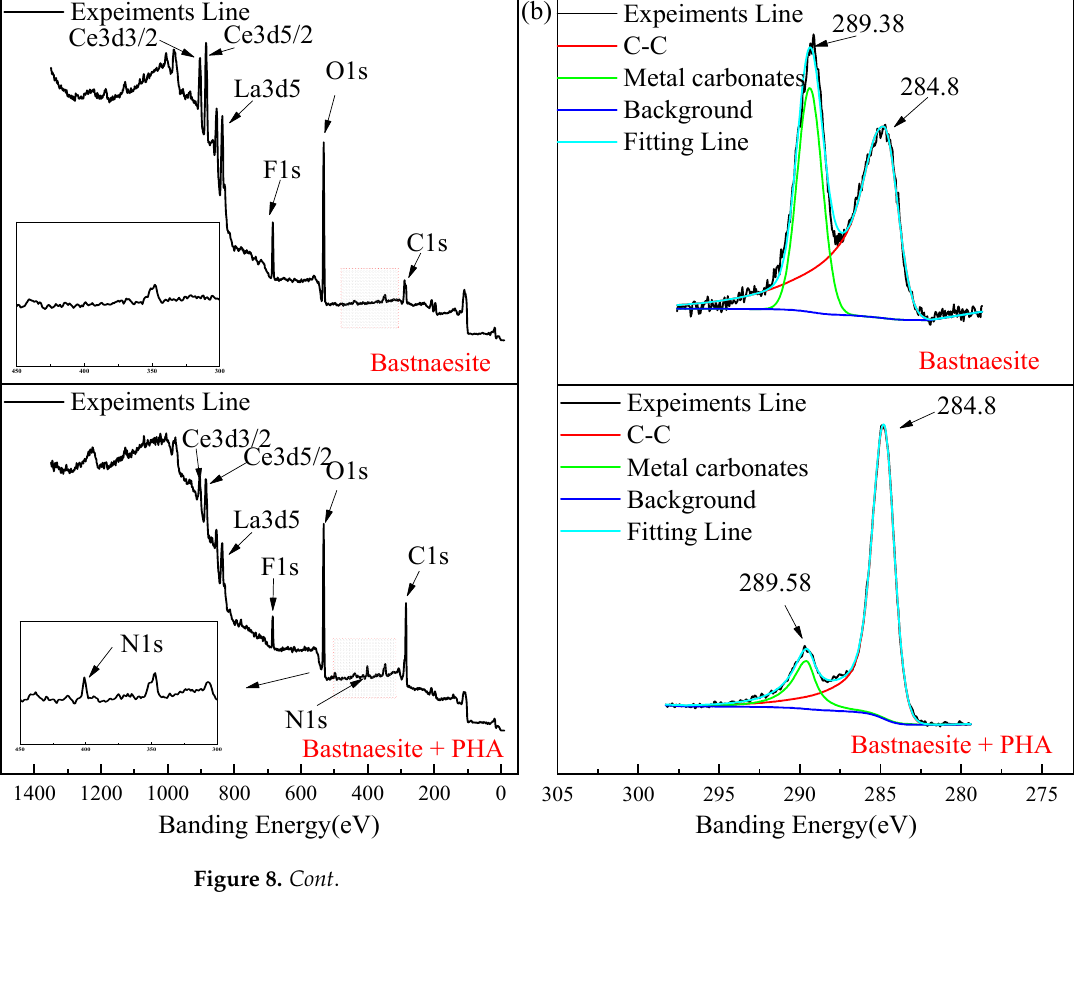
Table 3. Element concentration exist on bastnaesite surface.